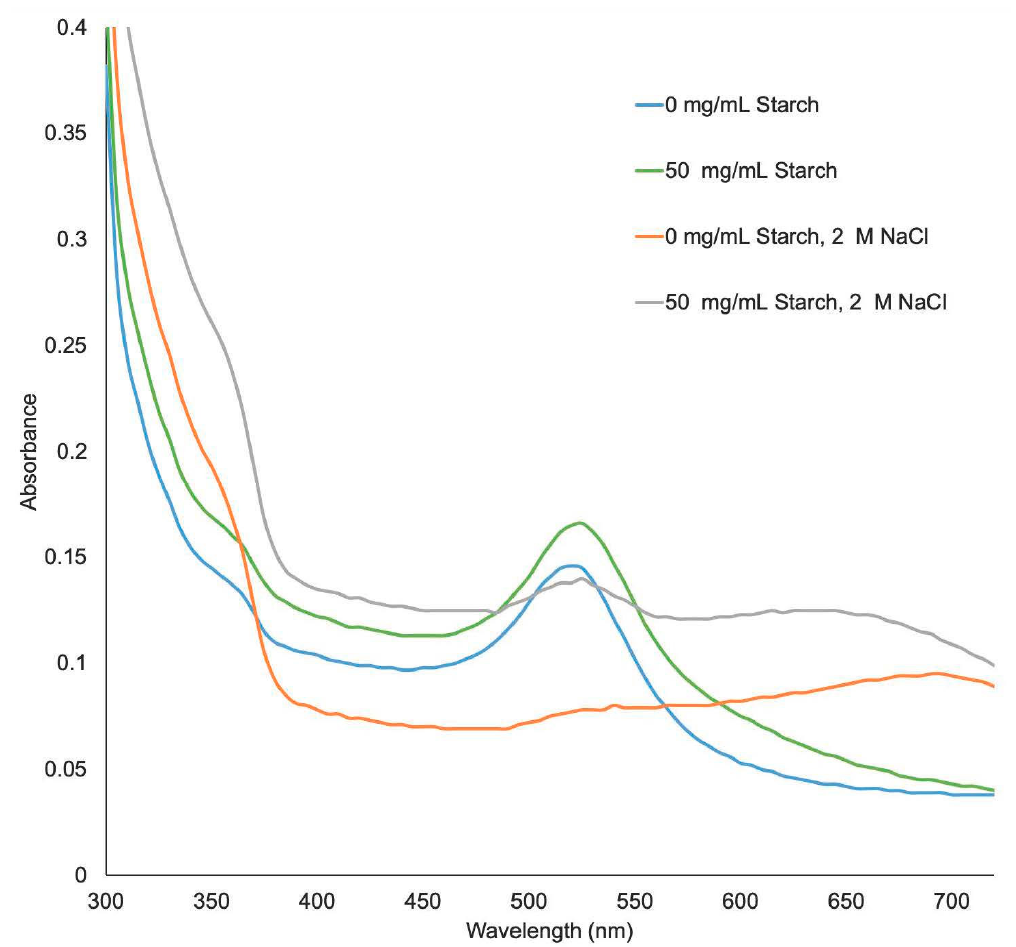
Figure 2. UV − Vis absorption spectra of AuNPs with and without Starch and/or NaCl.